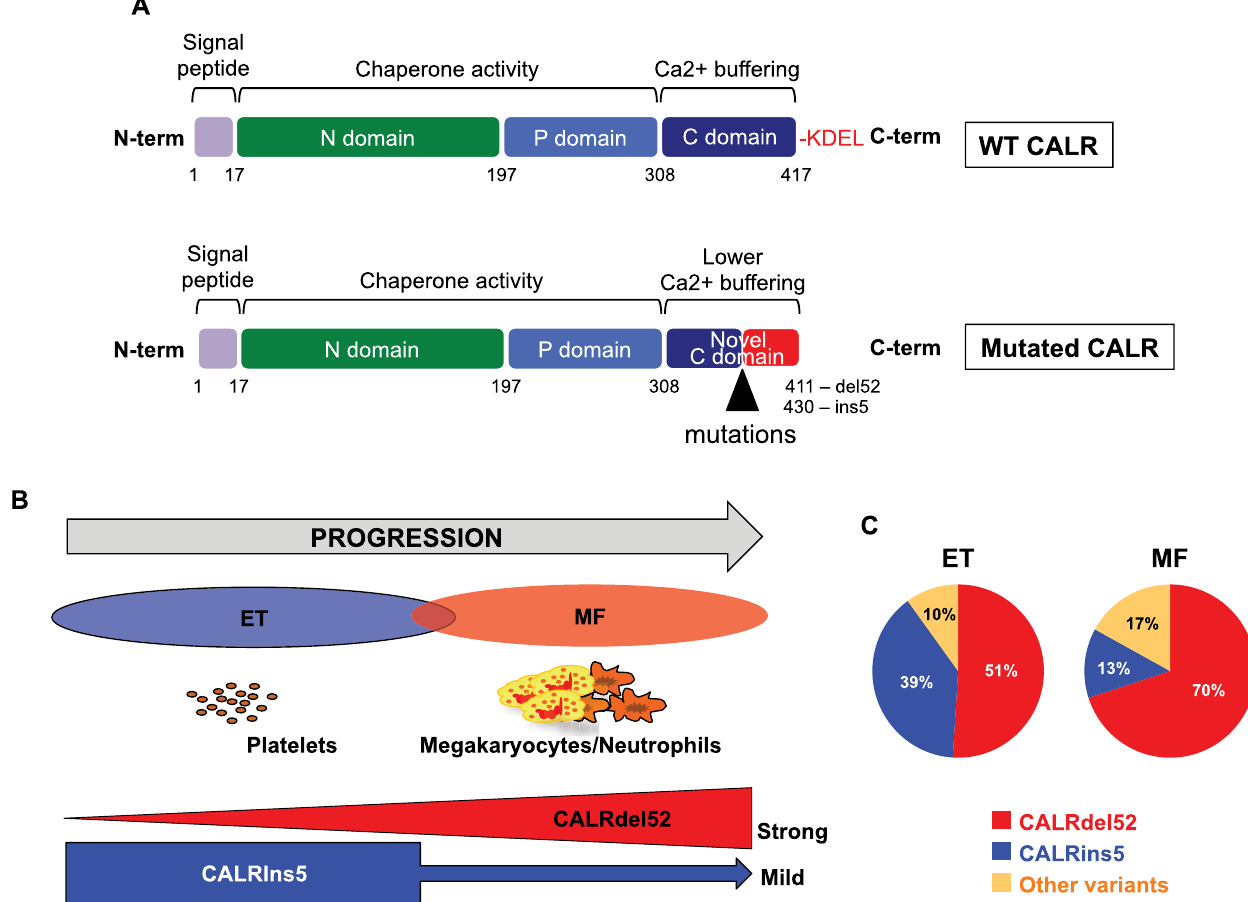
Figure 1. Calreticulin (CALR) and CALR mutation in essential thrombocythemia (ET) and myelofibrosis (MF). ( a ) CALR protein structure. CALR includes different domains responsible for the two major activities (chaperone and calcium buffering). The mutations lead to altered C-terminal part with loss of KDEL (retrieval and retention domain in endoplasmic reticulum) and generation of a new tail with low calcium- buffering activity. ( b ) Progression from ET to MF with CALR mutants. CALR del52 induces ET always progressing to MF in mice in contrast to CALR ins5. Thus, in vivo modeling of CALRdel52-induced pathologic effects induces a disorder characterized by a continuum between ET and MF. ( c ) Pie chart of the different CALR mutations in patients with ET and